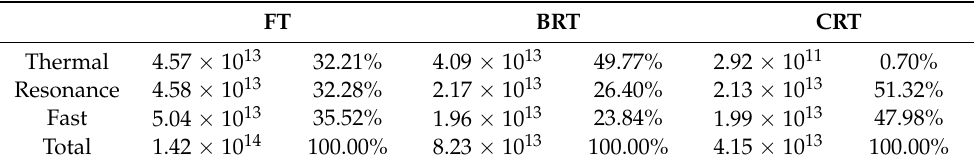
Figure 9. Neutron flux profile for the proposed MSTR-HPC core obtained by the MCNP simulation.